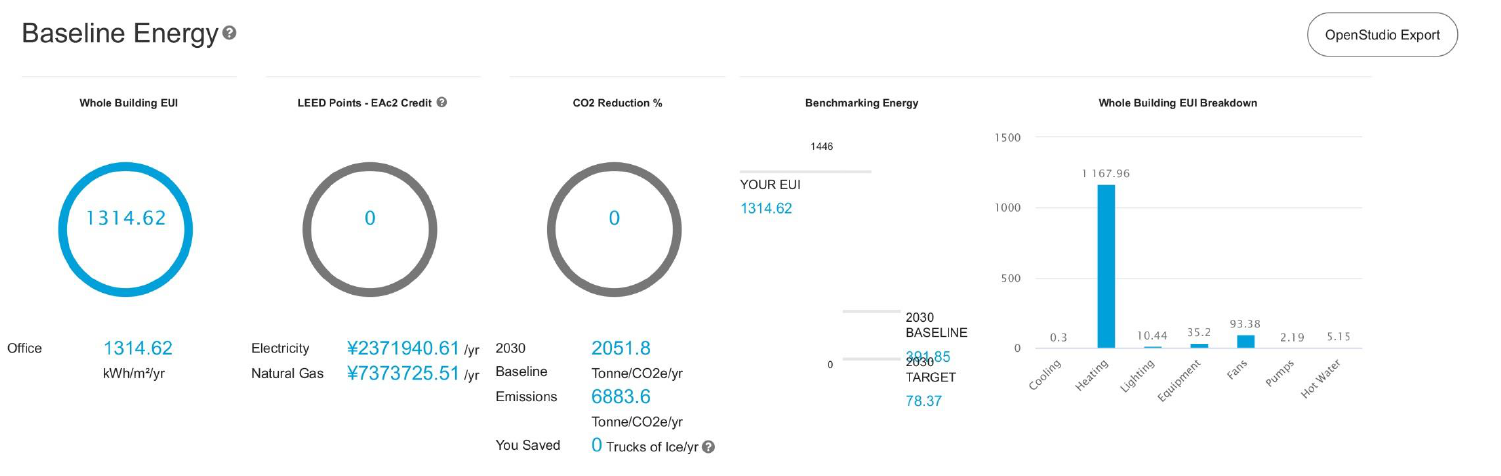
Figure A48. Zone 8 Tahé, Heilongjiang (post-COVID-19 84% scenario).